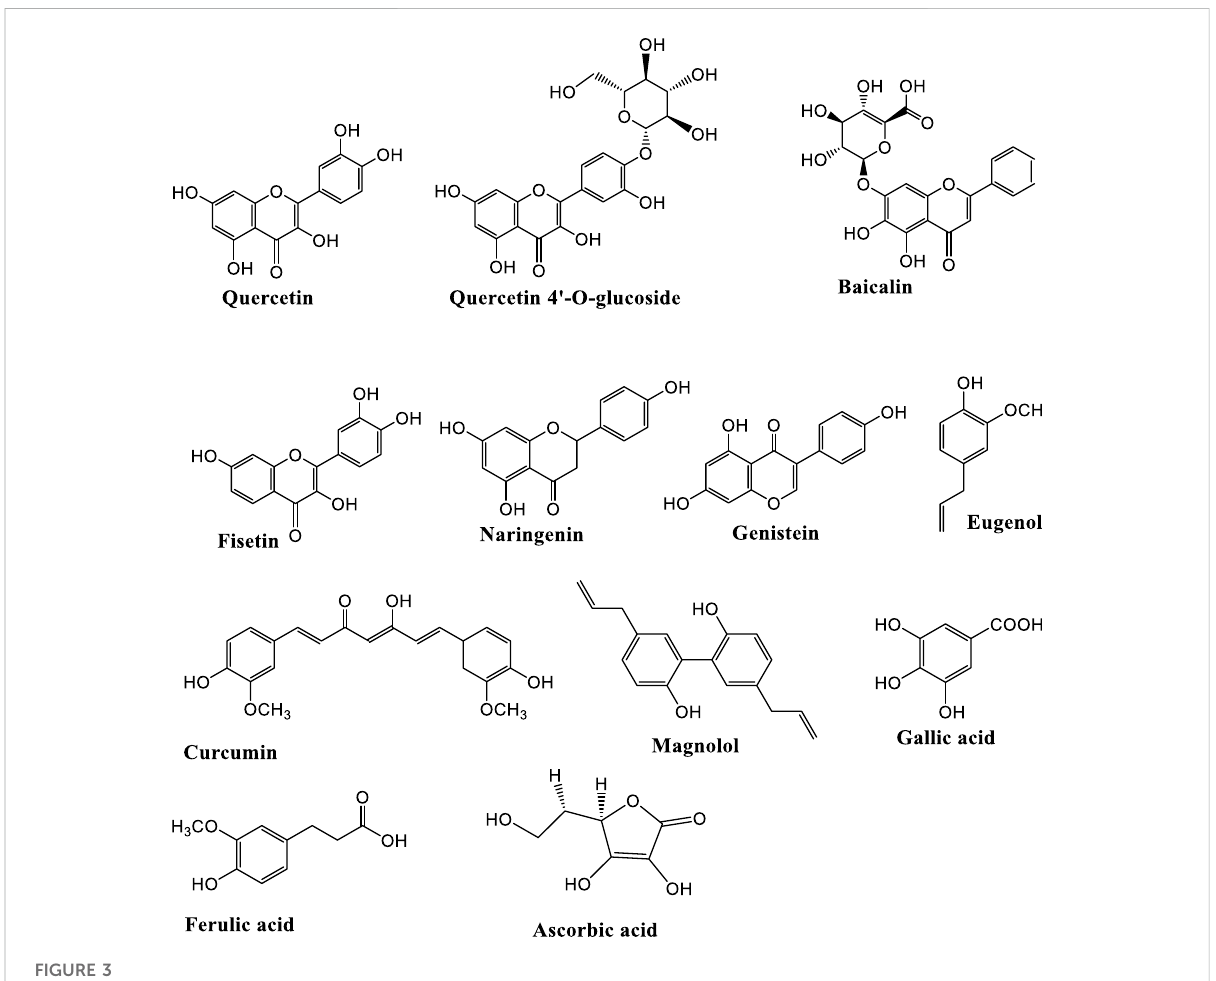
Chemical structures of important anti-depressant fl